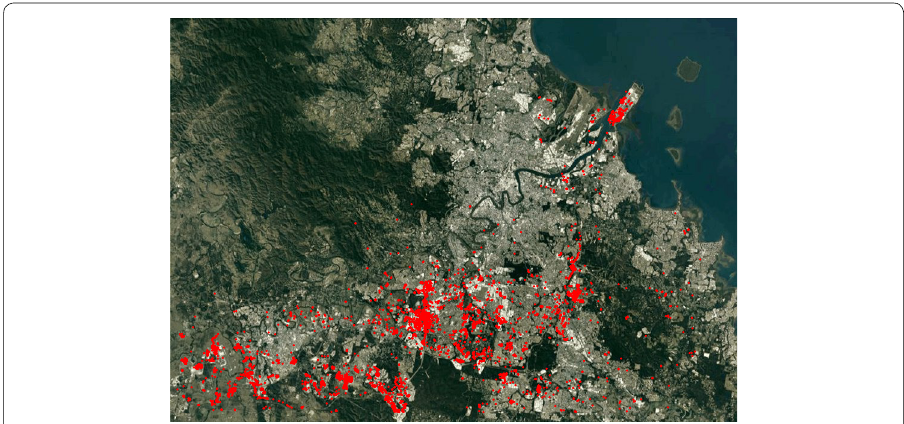
Fig. 3 Google image snapshot of the study area and the observed location of fire-ant colonies (indicated by red dots) over the study period 2001–2013